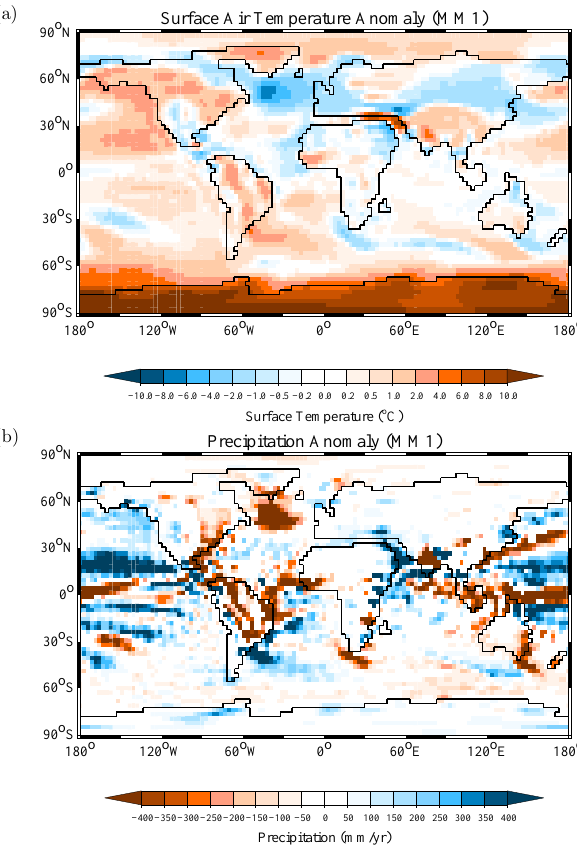
Fig. 6. (a) Annual mean surface temperature and (b) precipitation anomalies (MM1-minus-CTRL) for experiment MM1. Only the precipitation anomalies greater than one standard deviation for the long-term annual mean over the last 20 simulation years are